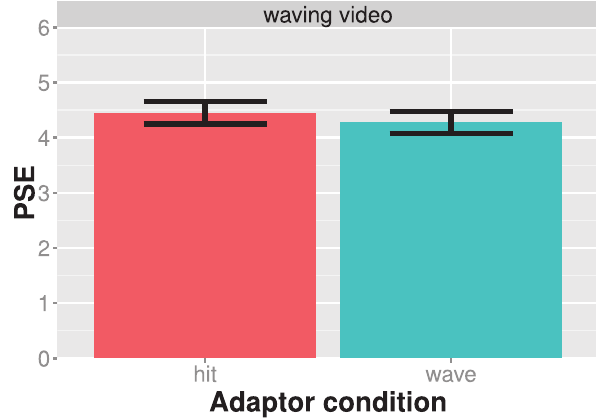
Figure 3. Results of experiment 1. The mean PSE values are shown for each experiment condition (different panels) and adaptor condition separately. The left panel shows the hitting context condition and the right panel shows the waving context condition. Larger PSE values indicate that the test stimulus showed more of a hitting action. Adaptation effects are assessed in a similar vein here and in all subsequent figures. Significant PSE differences between adaptor conditions of the same experiment condition are indicative of an adaptation effect. Bars indicate one standard error of the mean.